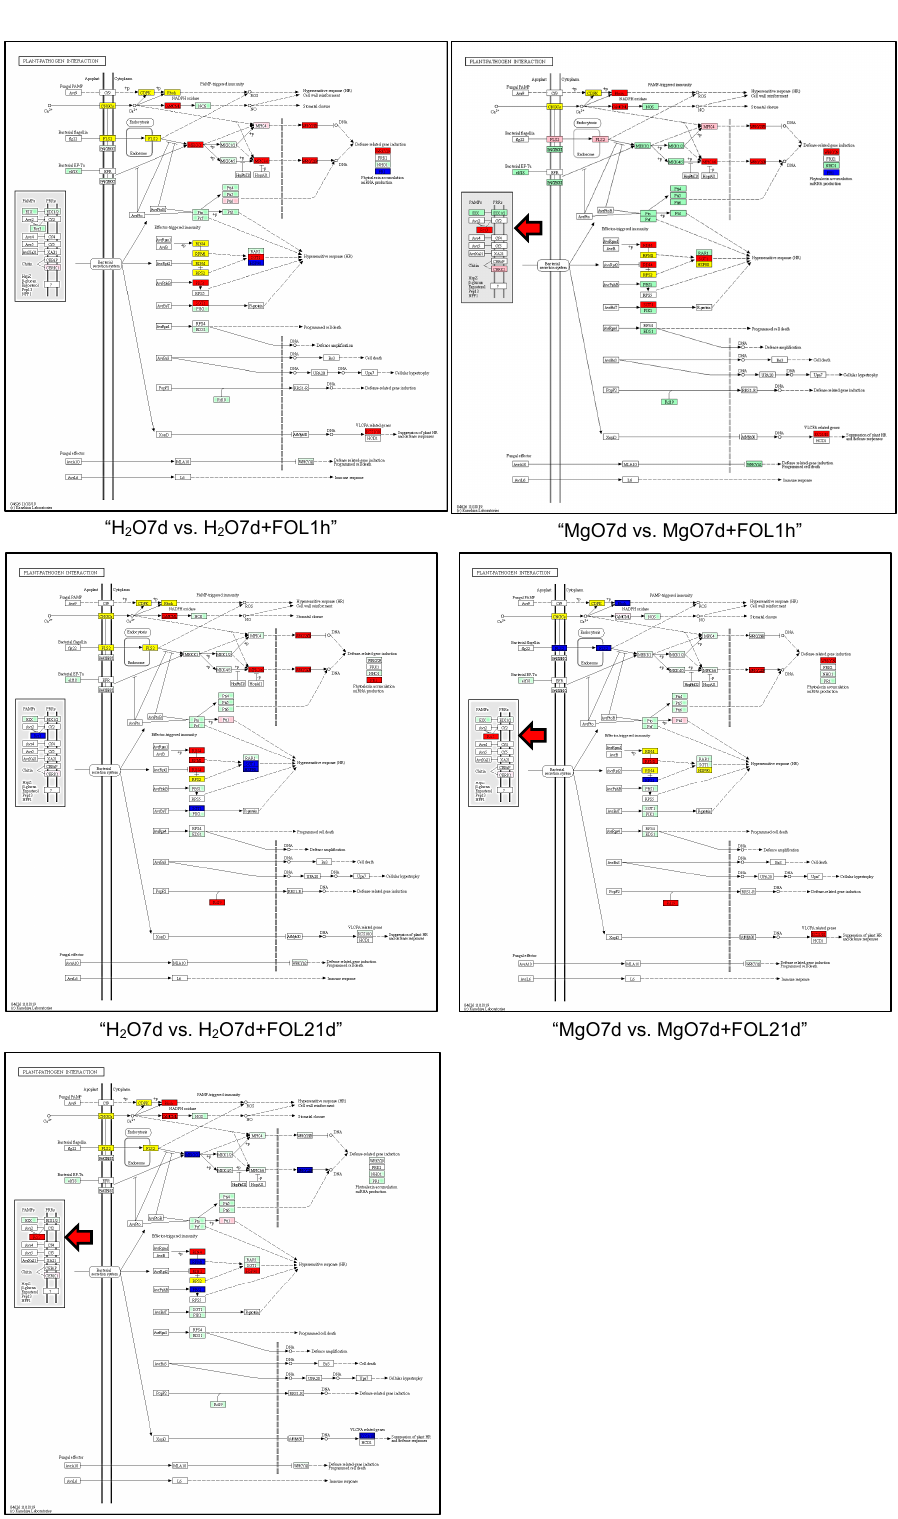
Figure 4. KEGG enrichment pathway: Plant-pathogen interaction. The red and blue boxes represent genes that are upregulated and downregulated, respectively. The yellow boxes represent genes that are both upregulated and downregulated. The red arrows show the upregulated Rcr3 gene. The green arrow shows the upregulated cyclic nucleotide gated channels ( CNGCs ) gene. Black solid arrows indicate stimulation/activation. Black dashed arrows indicate indirect effect.